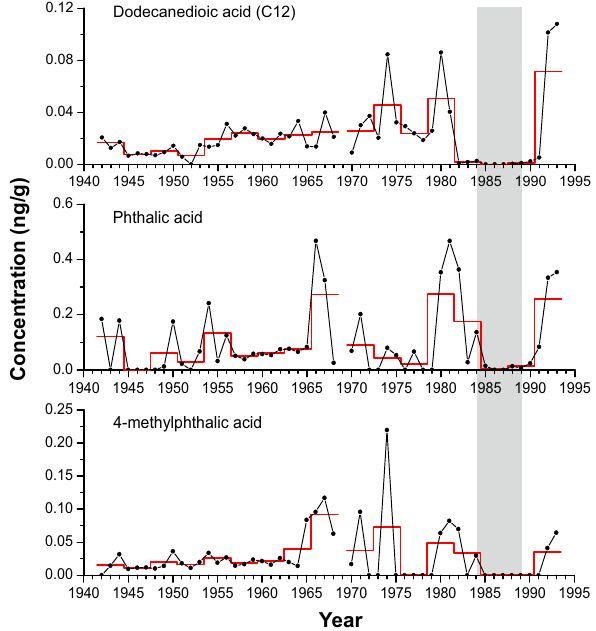
Figure 5. Ice core records of dicarboxylic acids (dodecanedioic acid, phthalic acid, and methylphthalic acid) in the Alpine ice core from upper Grenzgletscher (black dots: annual averages, red line: 3-year averages). The period influenced by meltwater (1984–89) is marked in